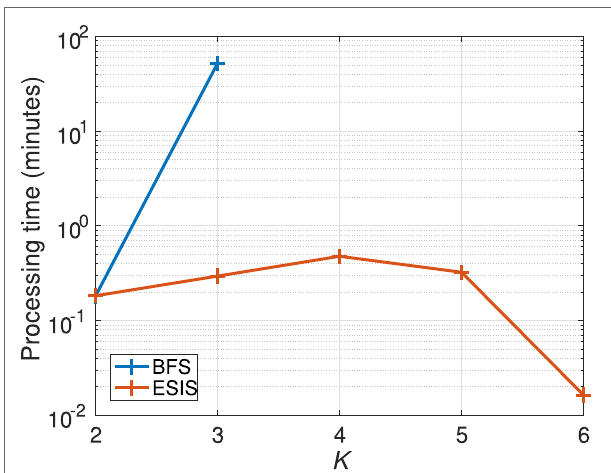
FIGURE 8 | Processing times for Experiment 2.